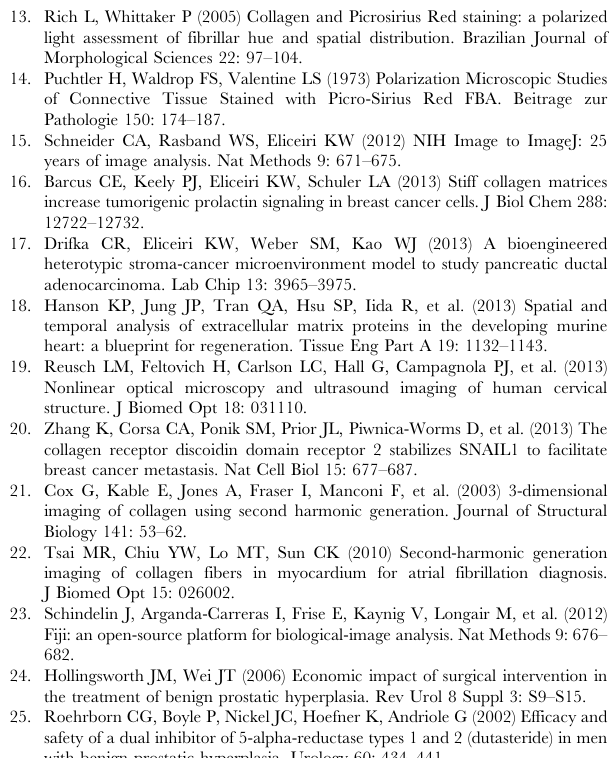
Figure S1 Experimental design for evaluation of fibril- lar collagen content and extracellular matrix (ECM) content in prostate tissues. A tissue microarray (TMA) containing tumor-adjacent normal prostate tissue (96 cores, in duplicate, from 48 patients) and glandular BPH (48 cores, in duplicate, from 24 patients) was stained with Masson’s trichrome (MTC) and Picrosirius red (PSR), and second harmonic generation (SHG) imaging was also used to identify collagen in a randomly sampled subset of TMA patients (n= 10 [normal